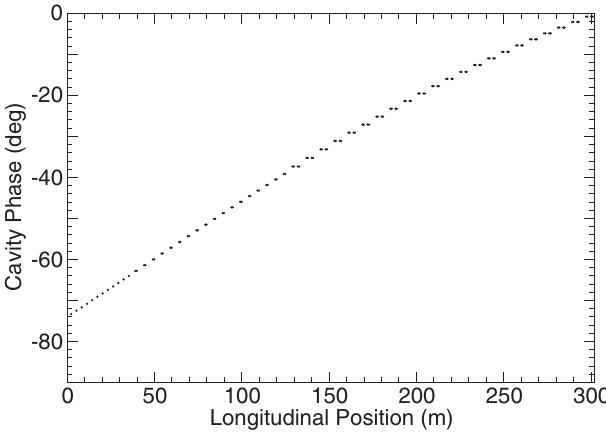
FIG. 22. Cavity phase vs position along the linac.